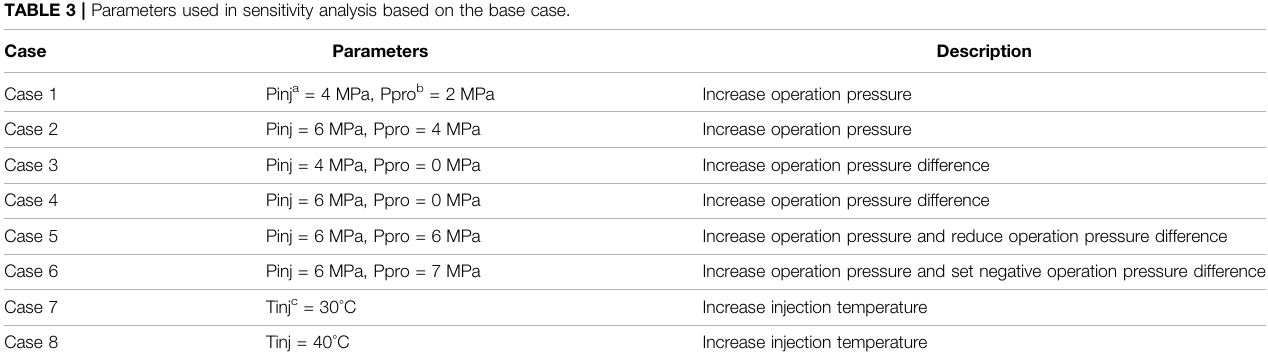
TABLE 3 | Parameters used in sensitivity analysis based on the base